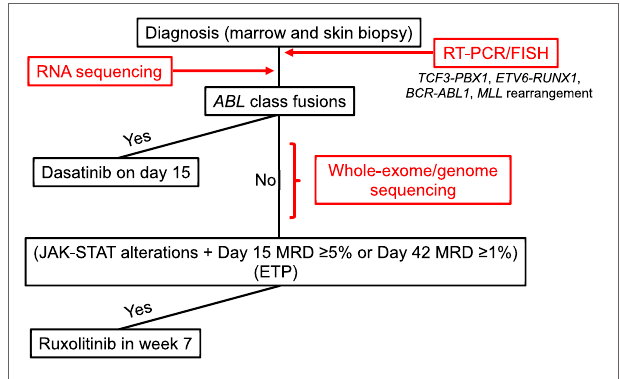
FiGUre 1 | Diagnostic procedure for and treatment of B- and T-acute lymphoblastic leukemia (ALL) with targetable lesions and early T-cell precursor ALL in Total XVII. FISH, fluorescence in situ hybridization; MRD, minimal residual